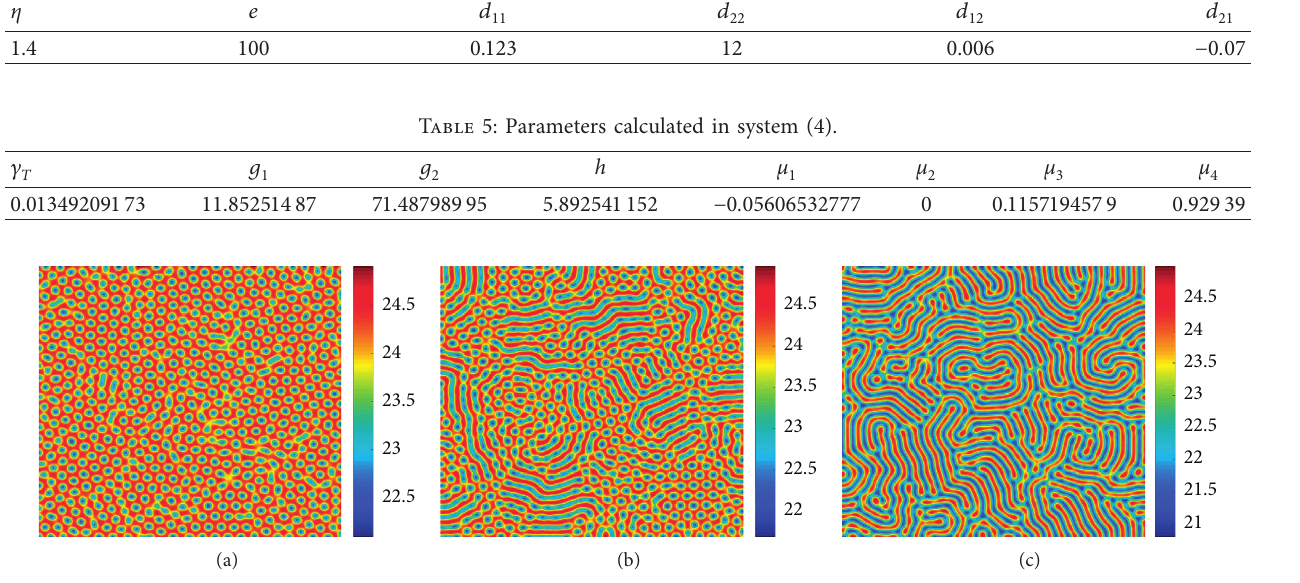
Figure 3: Unstable spot pattern, mixture of spots and stripes patterns, and stripe pattern of the predator. Other parameters are set as in Table 4, and (a) c � 0 . 0134, (b) c � 0 . 0131, and (c) c � 0 .